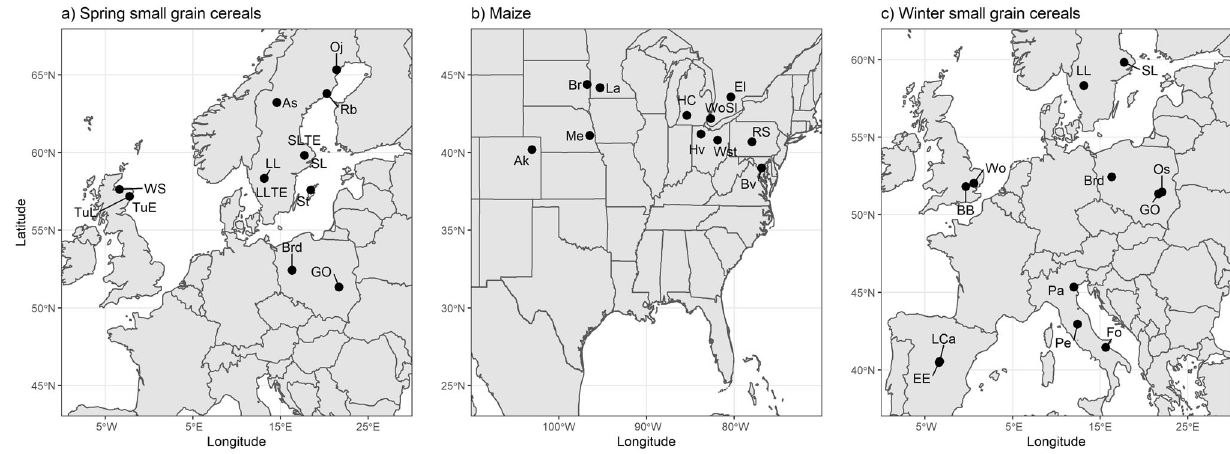
Fig. 1 Location of long-term agricultural experiments of each indicator crop. Spring-sown small grain cereals ( a ) were grown in Europe, maize ( b ) in North America, and winter-sown small grain cereals ( c ) in Europe. See Supplementary Table 1 for the clari fi cation of site codes and additional